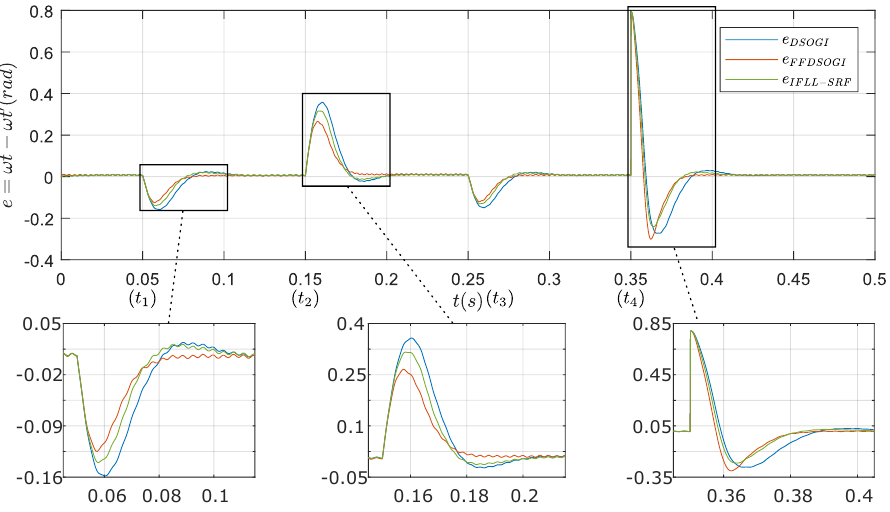
Figure 14. Estimated phase errors for the different methods during test #2.